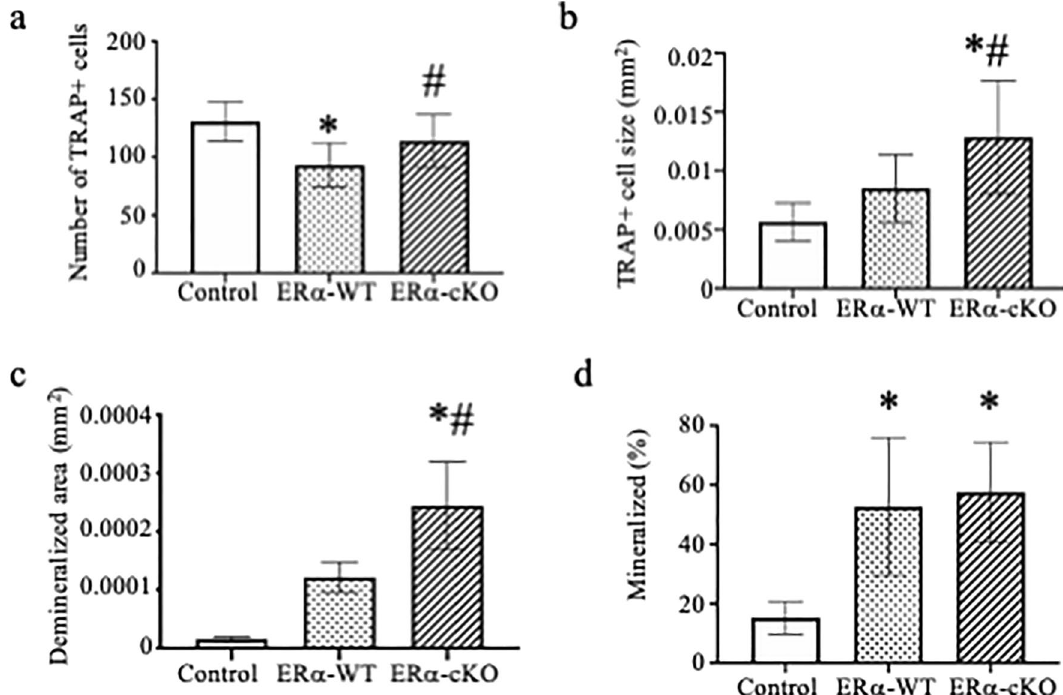
Figure 4. Conditioned media from estrogen receptor deficient muscle increases osteoclast differentiation. (A-C) Bone marrow macrophages were treated with M-CSF and RANKL to induce osteoclast differentiation. At the time of RANKL addition cultures were also given 5% Krebs (Control) or muscle conditioned media from ERα-WT or ERα-cKO animals. ( A ) Average number and ( B ) average size of TRAP positive multinuclear cells and ( C ) average size of demineralized area. ( D ) MC3T3-E1 cells were grown to confluency and then induced to differentiate with the addition of ascorbic acid. Krebs (Control) or muscle conditioned media from ERα-WT or ERα-cKO animals was given at the same time as ascorbic acid. Von Kossa assay was performed to measure percent mineralization of MC3T3 cell treated with 5% Krebs (control) or ERα-WT or ERα-cKO muscle conditioned media. * Significantly different from Control; # Significantly different from ERα-WT.